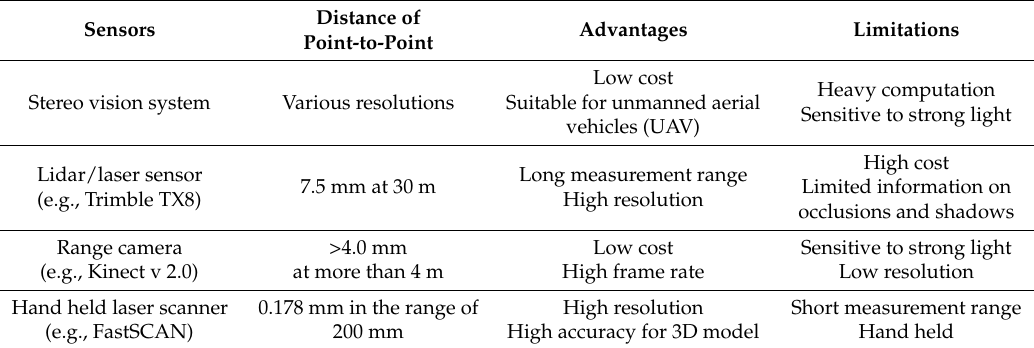
Table 4. Advantages and limitations of common sensors implemented in acquiring of geometric